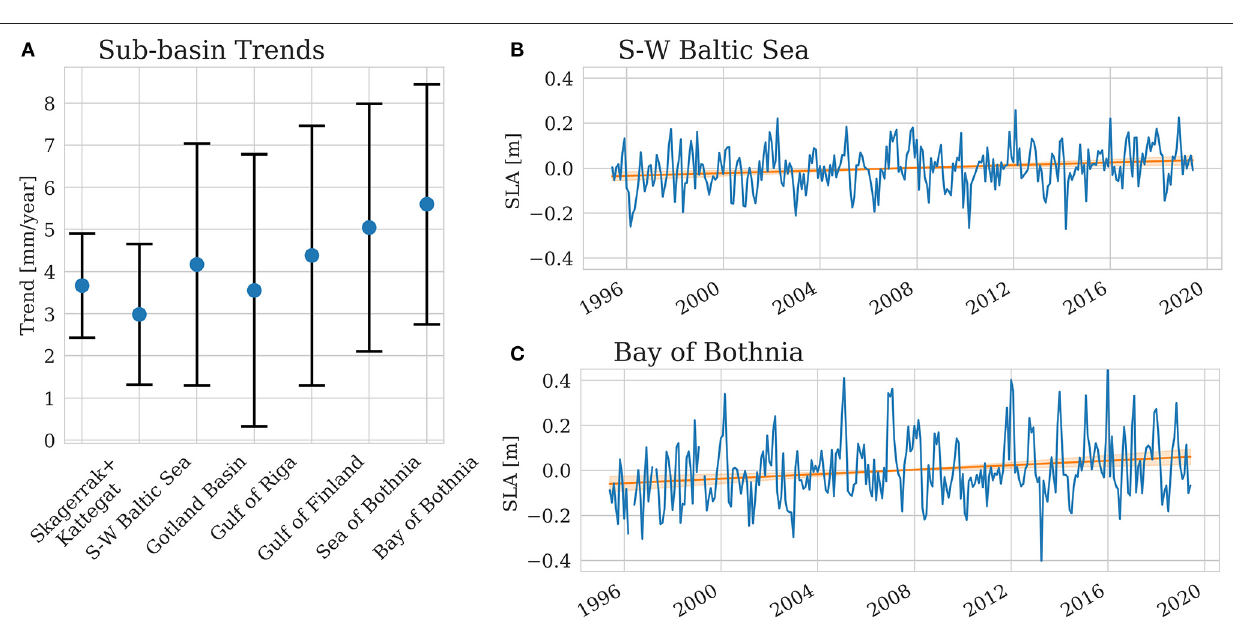
FIGURE 6 | (A) SL trends from gridded altimetry averaged across different sub-basins of the BS from May 1995 to May 2019. Corresponding uncertainties are reported as black error bars. (B,C) Monthly SL time series of the S-W Baltic Sea and the Bay of Bothnia. The linear trend is shown as a red line, with the shading representing its